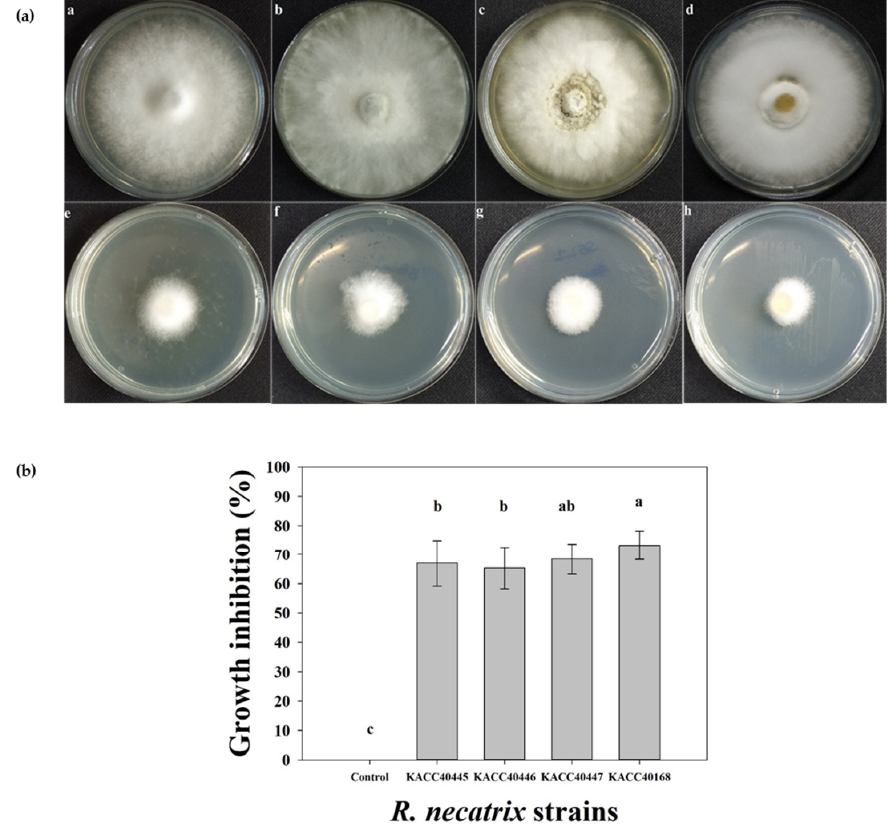
Figure 4. Effect of the volatile organic compounds (VOCs) produced by RDA1 on the mycelial growth of different strains of R. necatrix. ( a ) Plates a, b, c, and d are the controls for the R. necatrix strains KACC 40445, 40446, 40447, and 40168, respectively. Plates e, f, g, and h contain dual cultures of RDA1 and fungal pathogens. ( b ) The size of the zones of inhibition of the pathogenic fungi was used as a determinant of antifungal activities. The zone of inhibition was expressed as a percentage of the total area. Vertical bars indicate ± standard deviation ( n = 9). Different lowercase letters above each bar indicate significantly different means, as determined via Duncan’s multiple range tests.